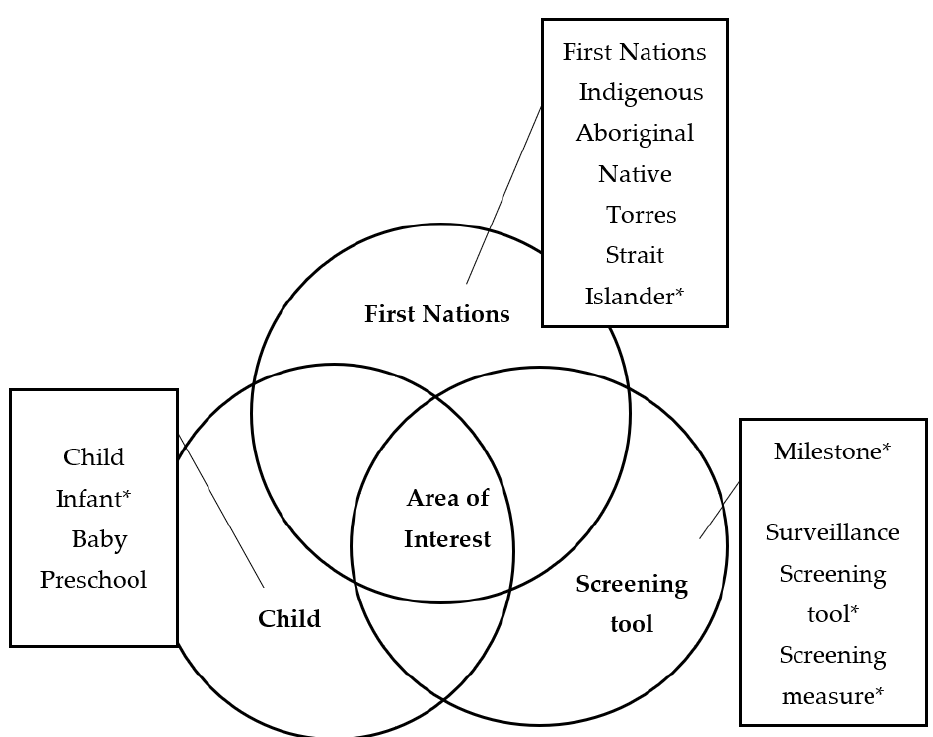
Figure 1. Diagram of search term clusters.